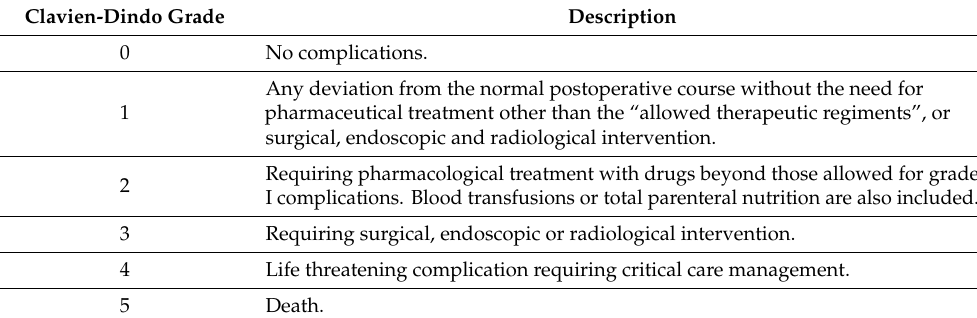
Table 1. Clavien-Dindo classification.